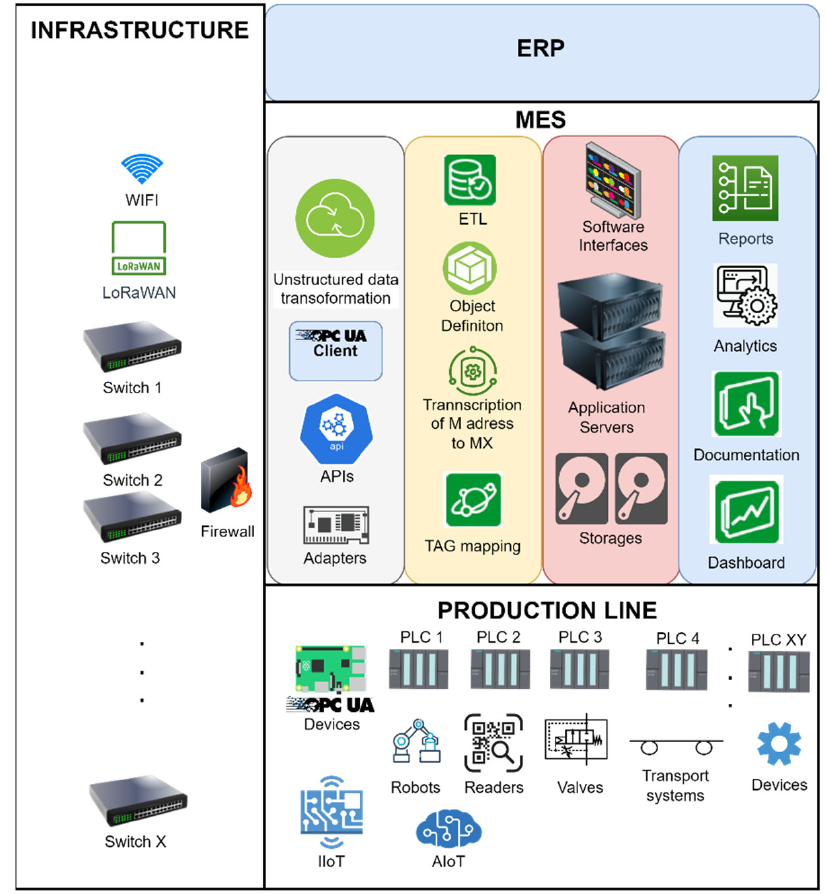
Figure 8. Data integration from heterogeneous control levels.